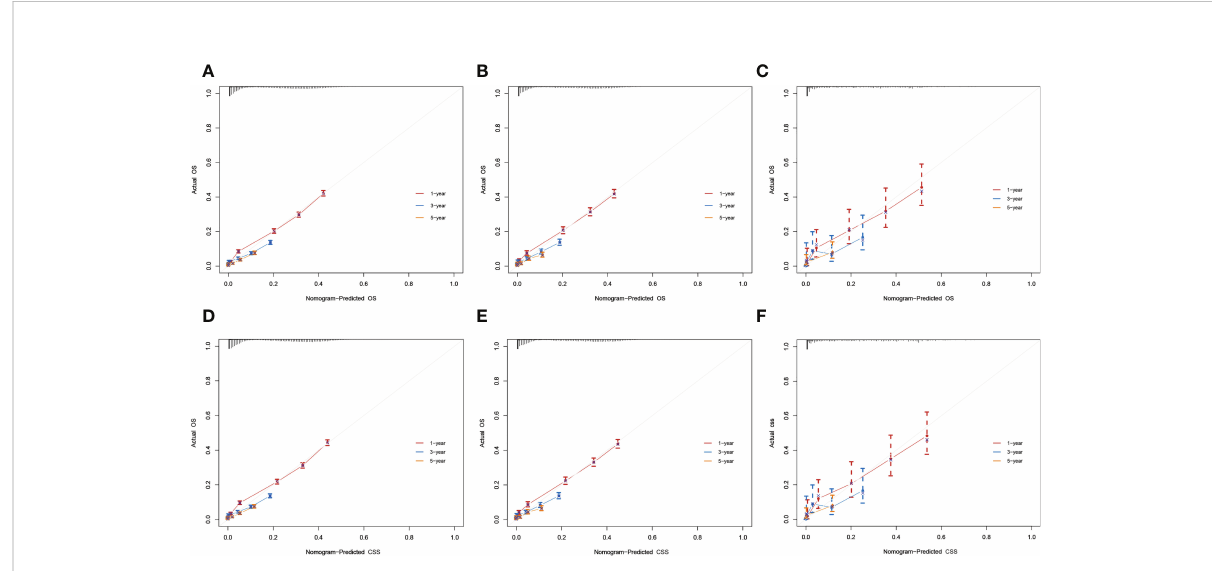
FIGURE 8 Calibration curves for 1-, 3-, and 5-year overall survival (OS) and cancer-speci fi c survival (CSS) rates of the nomogram predictions. (A – C) The training, internal validation, and external validation cohorts for the OS. (D – F) The training, internal validation, and external validation cohorts for the